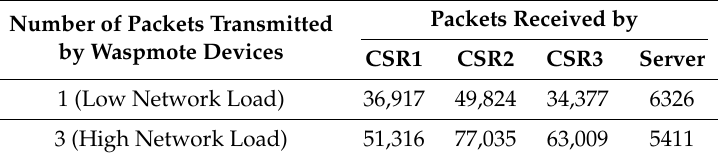
Table 13. Number of packets received by CSR devices and BLE server for each Waspmote device configuration in Collaborative Mesh with CSR devices retransmit each packet three